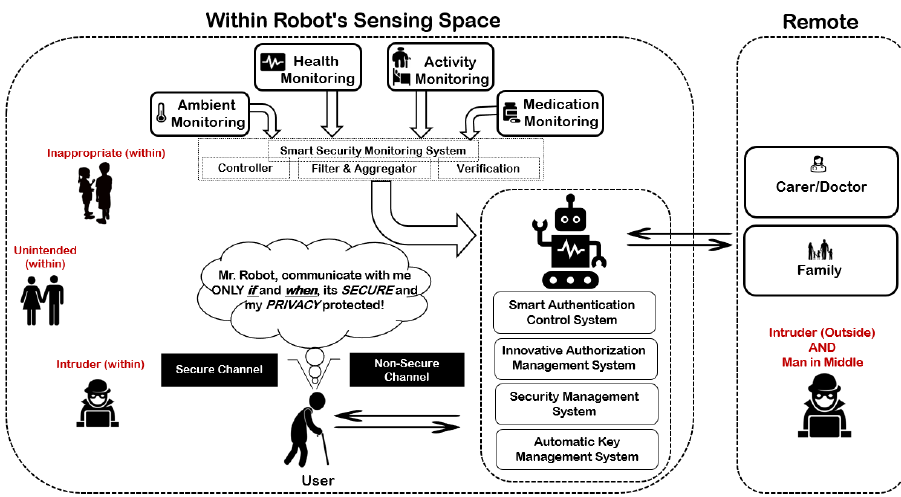
Figure 4. Threat Modelling of Single User Single AMRSys with IoT.